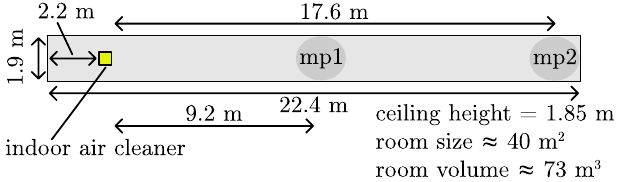
Figure 2. Config. II : the elongated hallway with the measurement locations mp1 and mp2. Figure not to scale with Figure